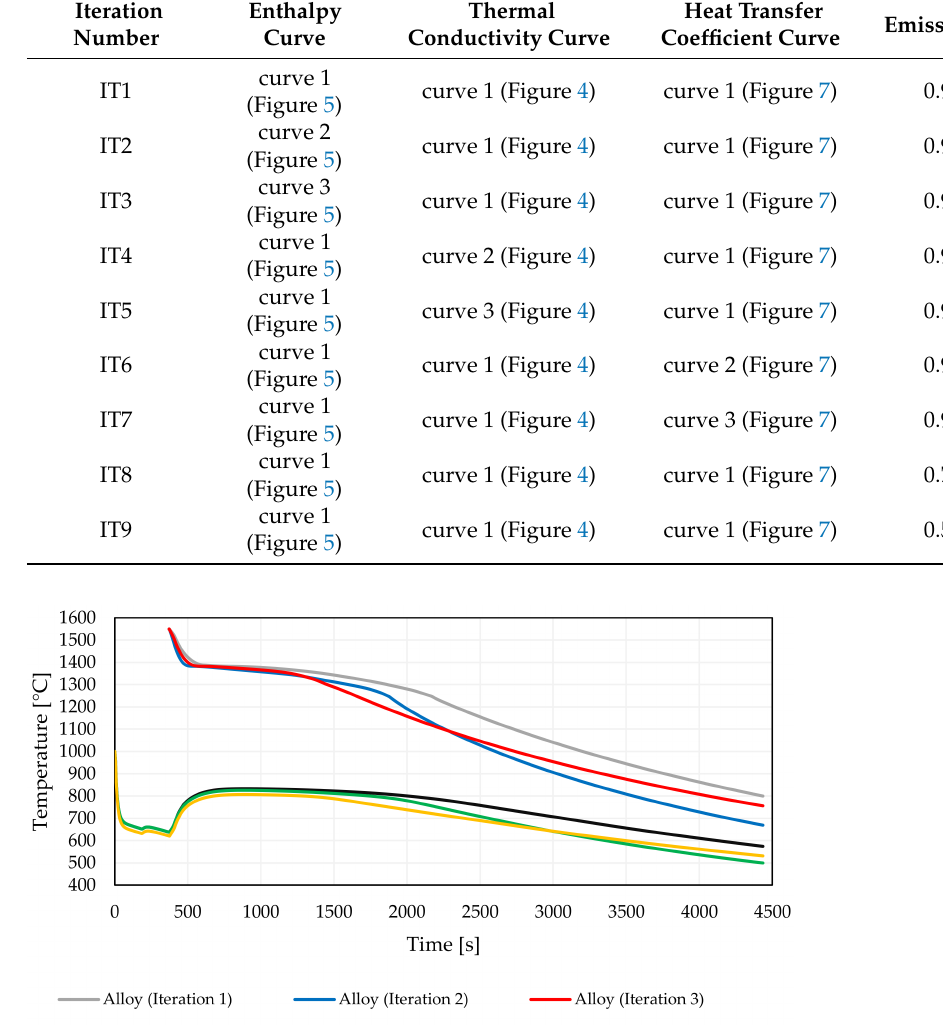
Figure 13. Evaluation of the influence of enthalpy on the alloy and wool blanket temperature results.